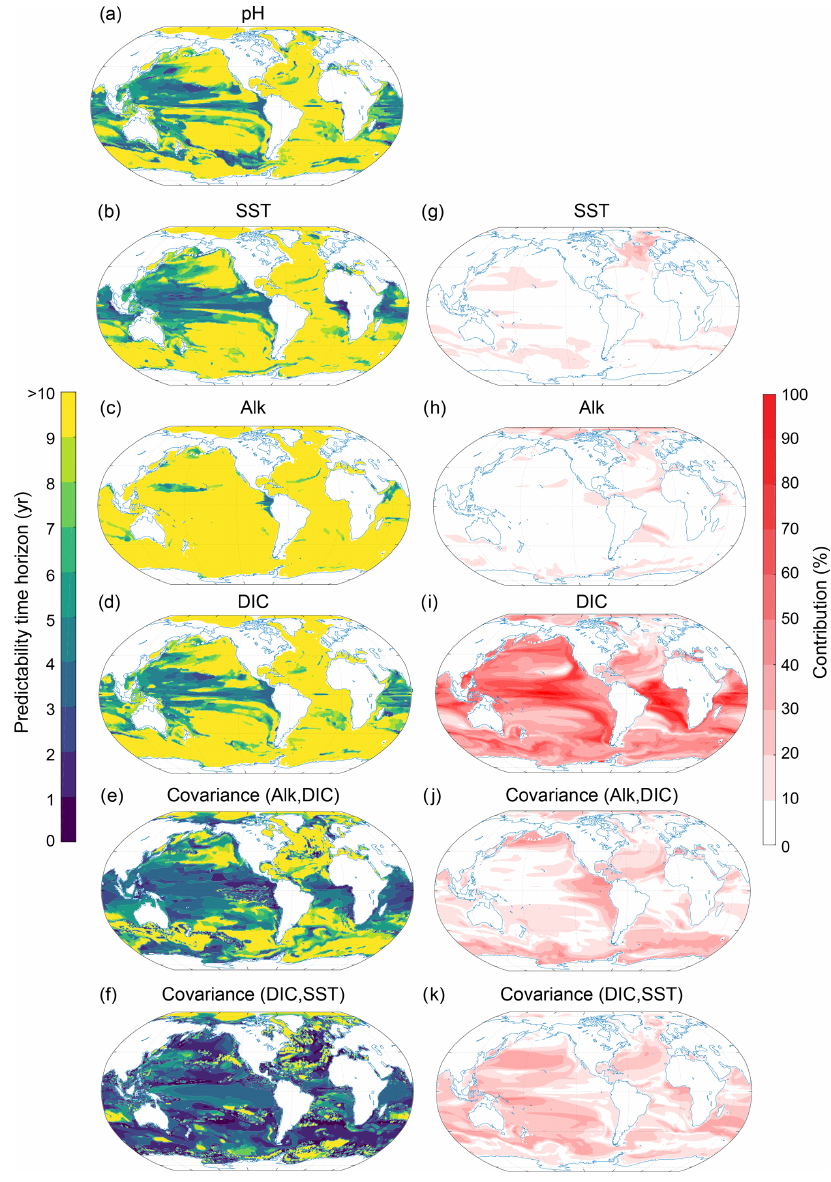
Figure 10. Same as Fig. 9, but at 300m